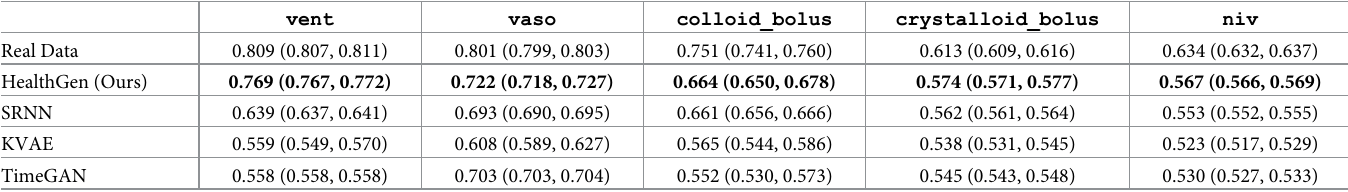
Table 1. Comparison of AUROC scores for all predictive tasks between HealthGen and the baseline models. The 95% confidence interval of the mean value is pre- sented in parentheses and is estimated via bootstrapping with 30 samples. vent